Question: Briefly state, in one sentence, what is plotted here.
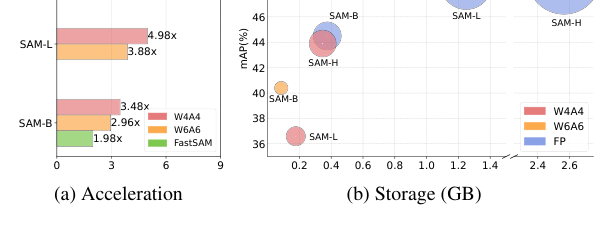
Answer: (a) Theoretical acceleration rate (100 prompts) vs. all SAM models. (b) Accuracy vs. storage.